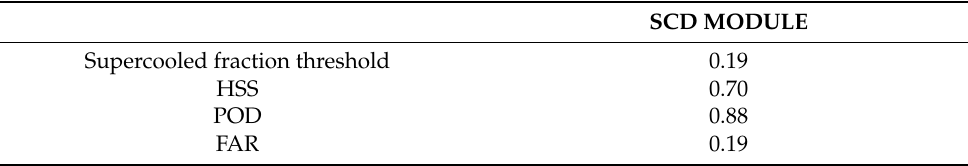
Figure 8. Supercooled water detection statistics. POD, FAR, and HSS are shown as functions of the supercooled droplet fraction within the ATMS pixel. Table 7. Error statistics of the SCD module.